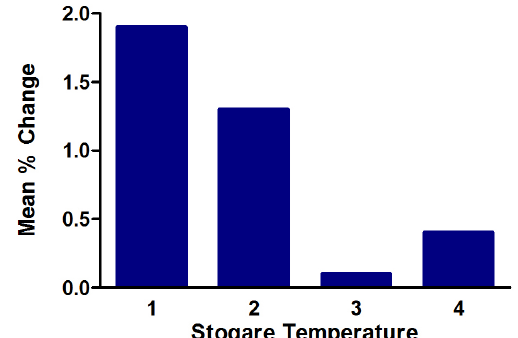
FIGURE 1 - Mean % changes in the conductivity of base from zero time to 60 days. 1= 8 °C, 2= 25 °C, 3= 40 °C, 4= 40 °C + 75% RH.